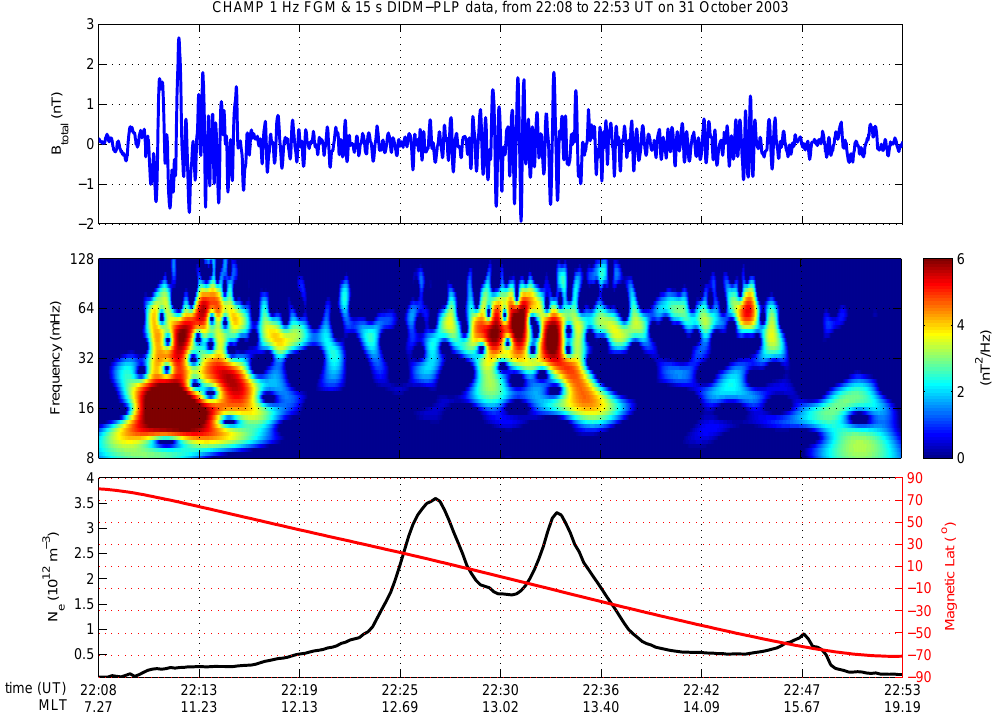
Fig. 5. The CHAMP track from 22:08 to 22:53UT on 31 October 2003. From top to bottom are shown the time series of the CHAMP total magnetic field, calculated from the 1Hz FGM data after applying a 16mHz high-pass filter, its corresponding wavelet power spectrum as well as the temporal variation of the CHAMP electron density data along with its magnetic latitudinal dependence indicating that the satellite was moving from the north to the south pole. The corresponding MLT values are also given at the bottom of the graph. A prominent Pc3 ULF wave is observed starting at around 22:25UT and lasting ∼ 20min. The strong ionospheric currents’ signatures near the poles covering many frequencies can also be seen in this